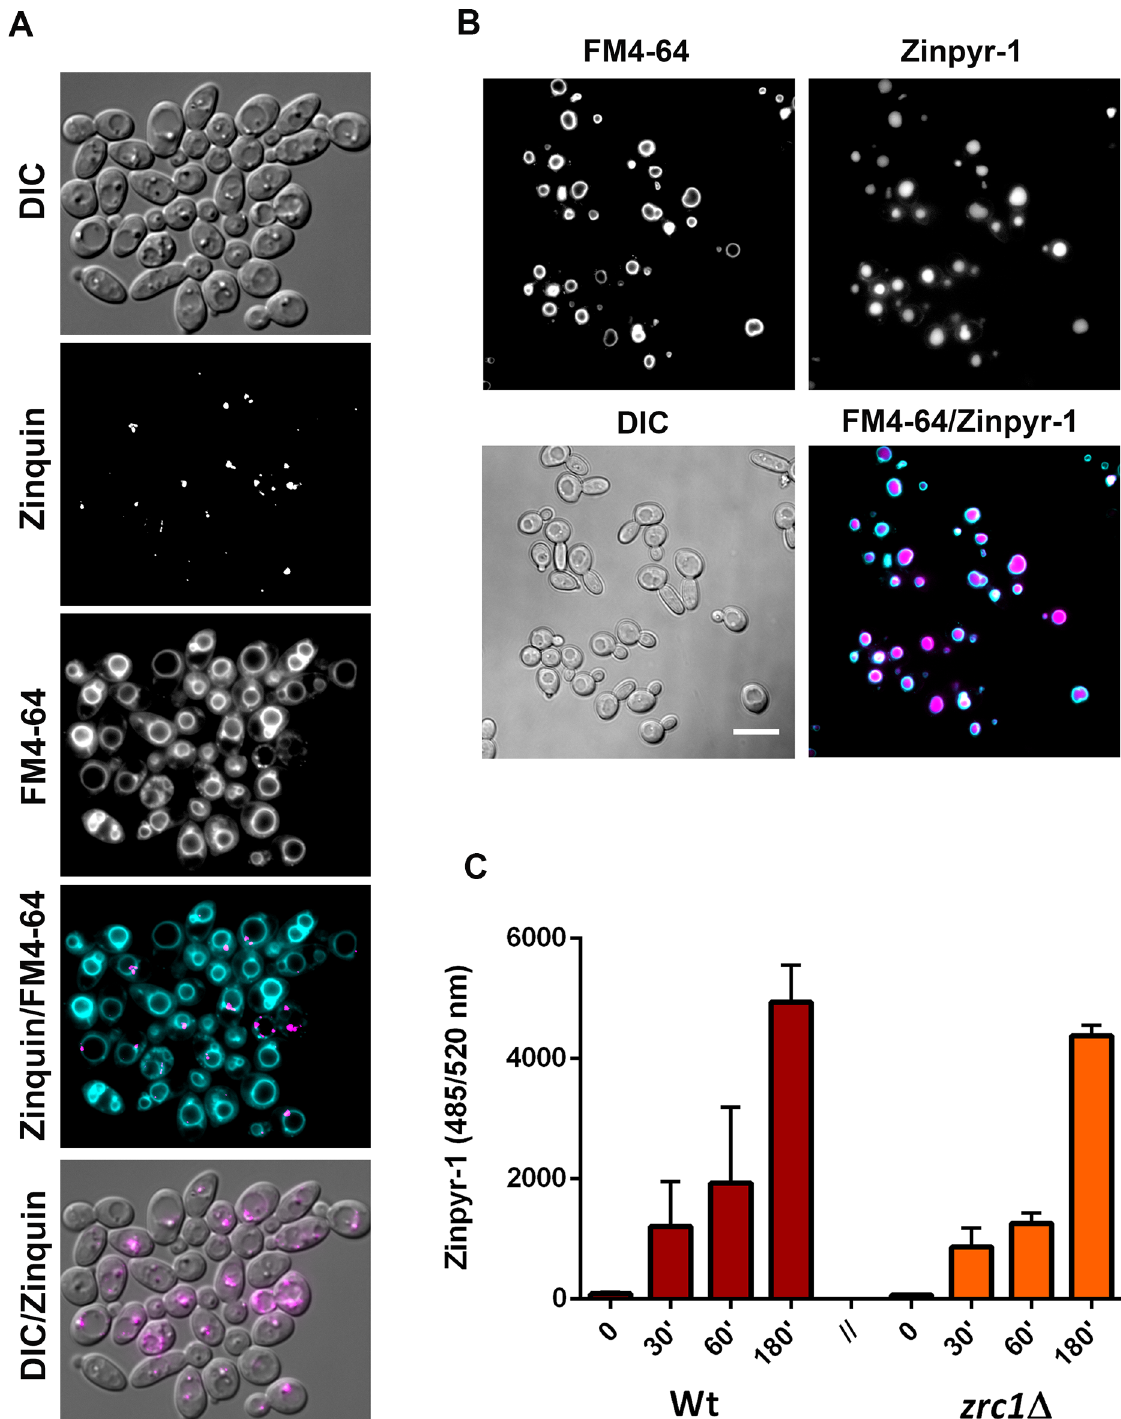
Fig 9. Relationship between zincosomes and vacuole in C . albicans . ( A ) Cells were co-stained with zinquin (zincosomes) and FM4-64, which stains the fungal vacuole membrane. Note that zincosomes are not intra-vacuolar. ( B ) The zinc-specific probe Zinpyr-1 can be used to detect vacuolar zinc in C . albicans . Cells were co-stained with Zinpyr-1 and FM4-64. Note that Zinpyr-1 stains vacuolar zinc in C . albicans ( C ) Zrc1 is not required for vacuolar zinc import. Cells were loaded with Zinpyr-1, pulsed with 25 μM zinc and Zinpyr-1 fluorescence determined at 0, 30, 60 and 180 minutes post pulse. Experiments performed at least